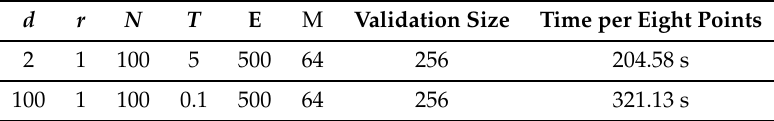
Table 2. Parameters for the equation with quadratic